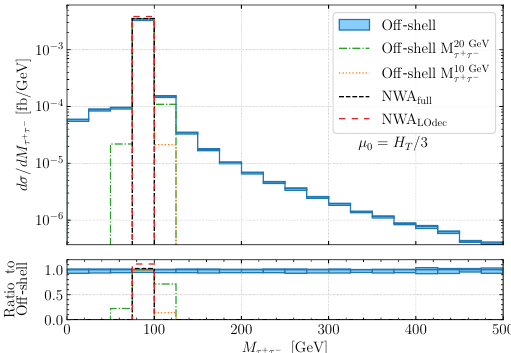
Figure 10 . Differential cross-section distribution for pp → e + ν e µ − ¯ ν µ b ¯ b τ + τ − + X at the LHC with √ s = 13 TeV as a function of M . The upper panel shows the NLO QCD prediction for the full τ + τ − off-shell case as well as for NWA full and NWA LOdec . Also given is the full off-shell result with the additional | M − m Z | < 20 (10) GeV cut. Furthermore, we provide theoretical uncertainties as τ + τ − obtained from the scale dependence for the full off-shell case. The lower panel displays the ratios to the full off-shell result. The scale choice is µ R = µ F = µ 0 = H T / 3 . The cross sections are evaluated with the NNPDF3.1 PDF